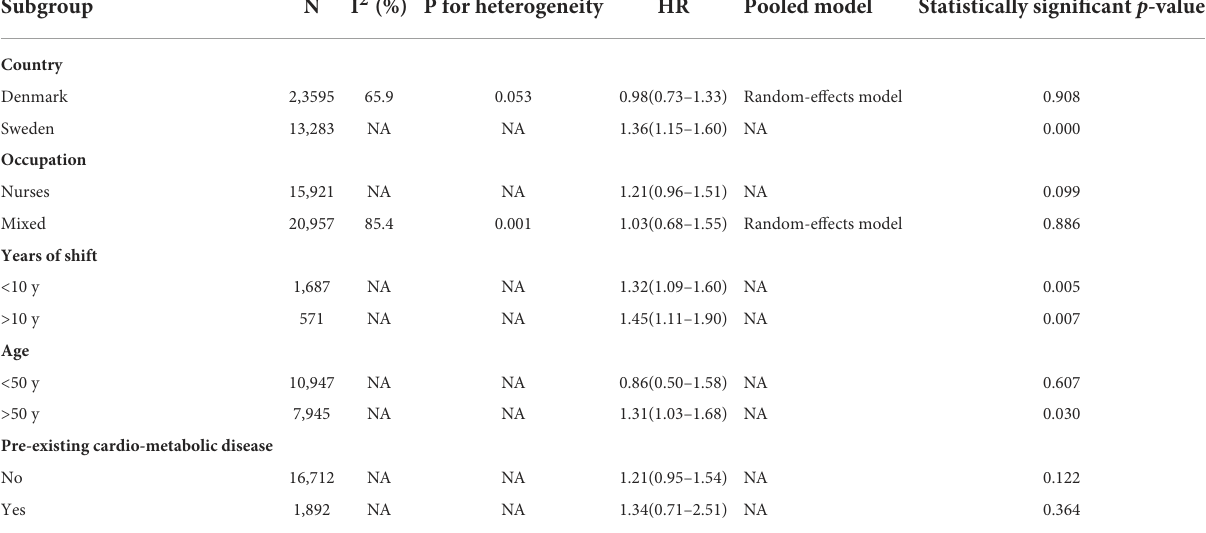
TABLE 3 Subgroup analysis of the association between shift work and risk of dementia. Subgroup N Pooled model Statistically significant p